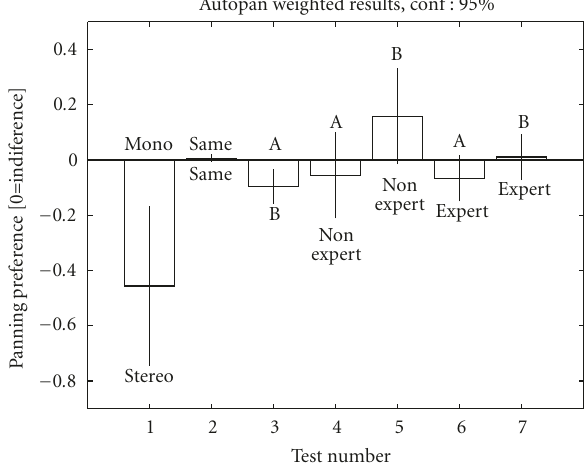
Figure 8: Summarized results for the subjective evaluation.